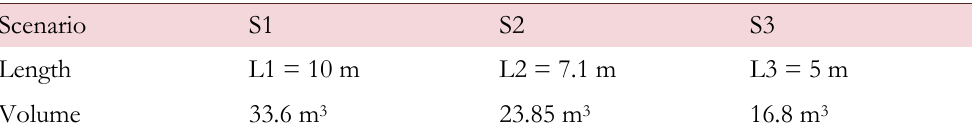
Table 1: Considered scenarios and corresponding tributary volume lengths.